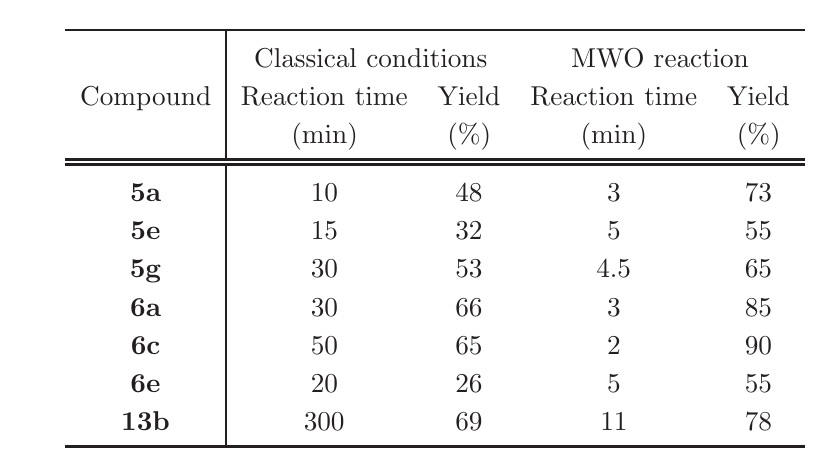
Table 1 Comparisons between “classical” and microwave